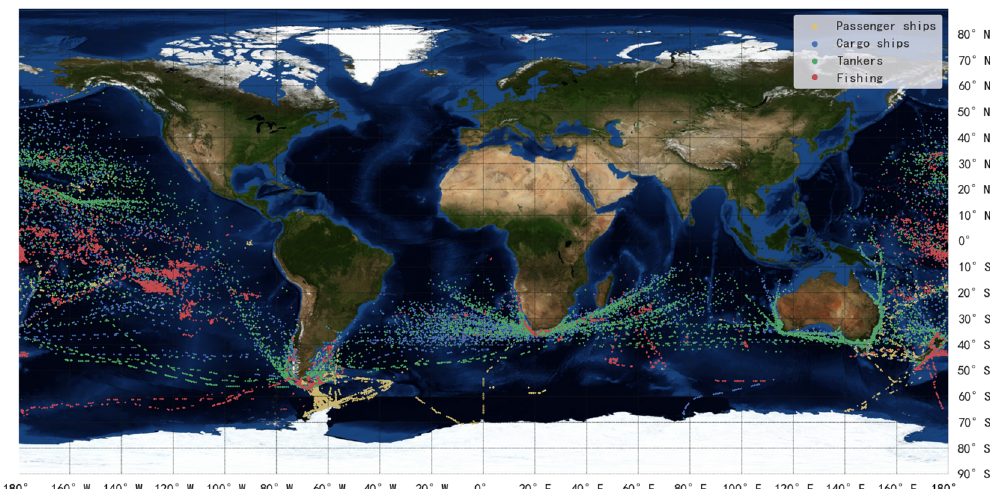
Figure 16. Dynamic data used in experiments.